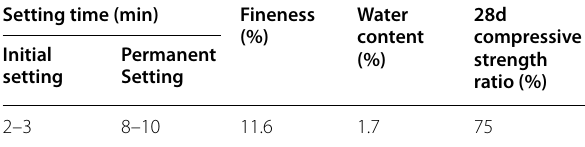
Table 3 Basic properties of the accelerating agent Setting time (min)